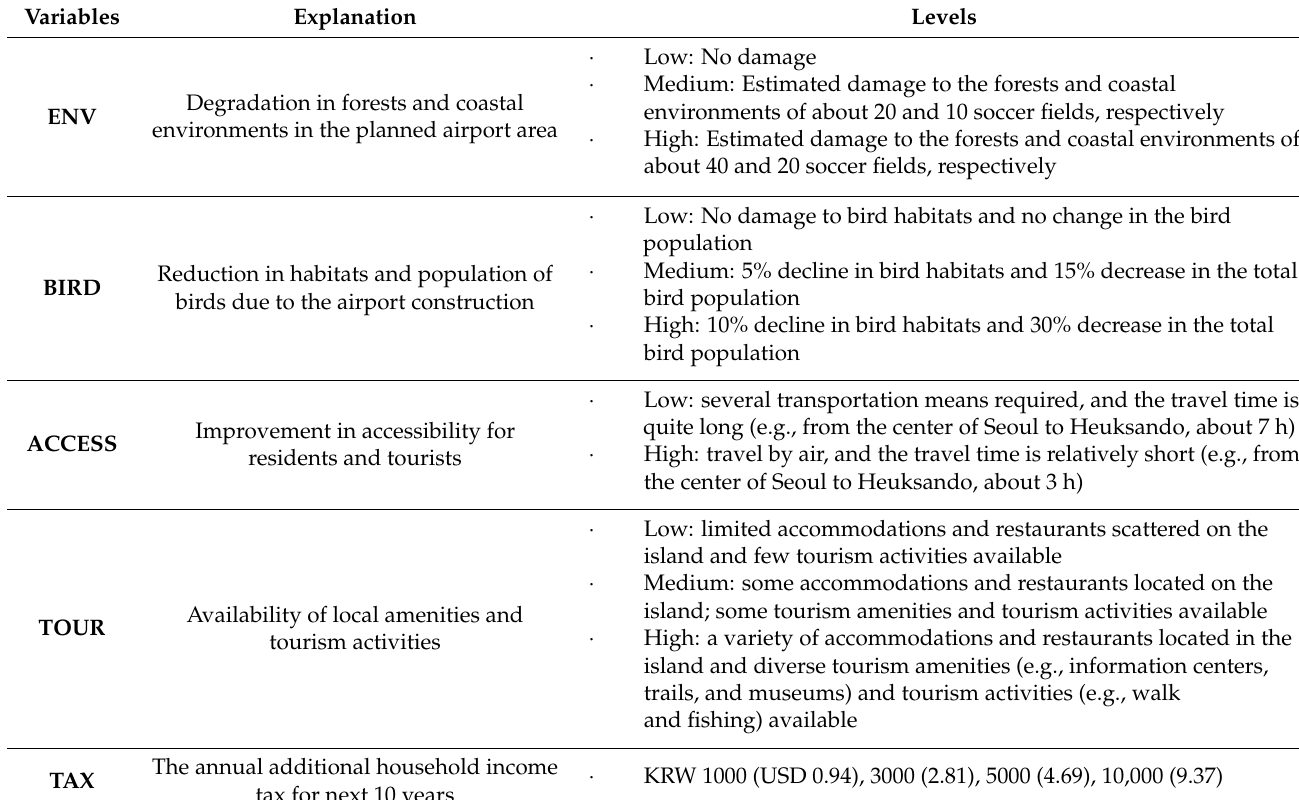
Table 1. Explanation of the attributes and